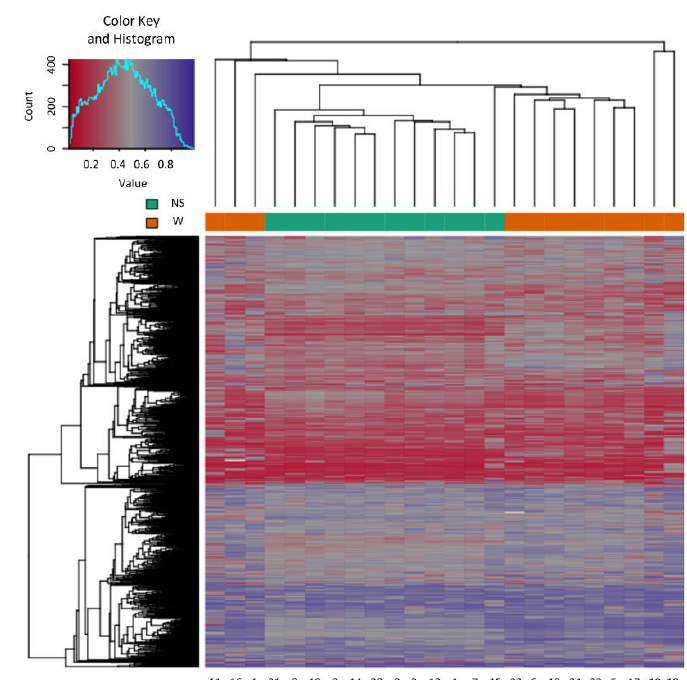
Figure 1. Heatmap showing the hierarchal clustering of the 1000 most variable loci with the highest variance across the wart (W) and normal skin (NS) samples. Clustering incorporated average linkage and Manhattan distance. The numbers at the bottom horizontal axis (1 to 24) stand for the patient samples.